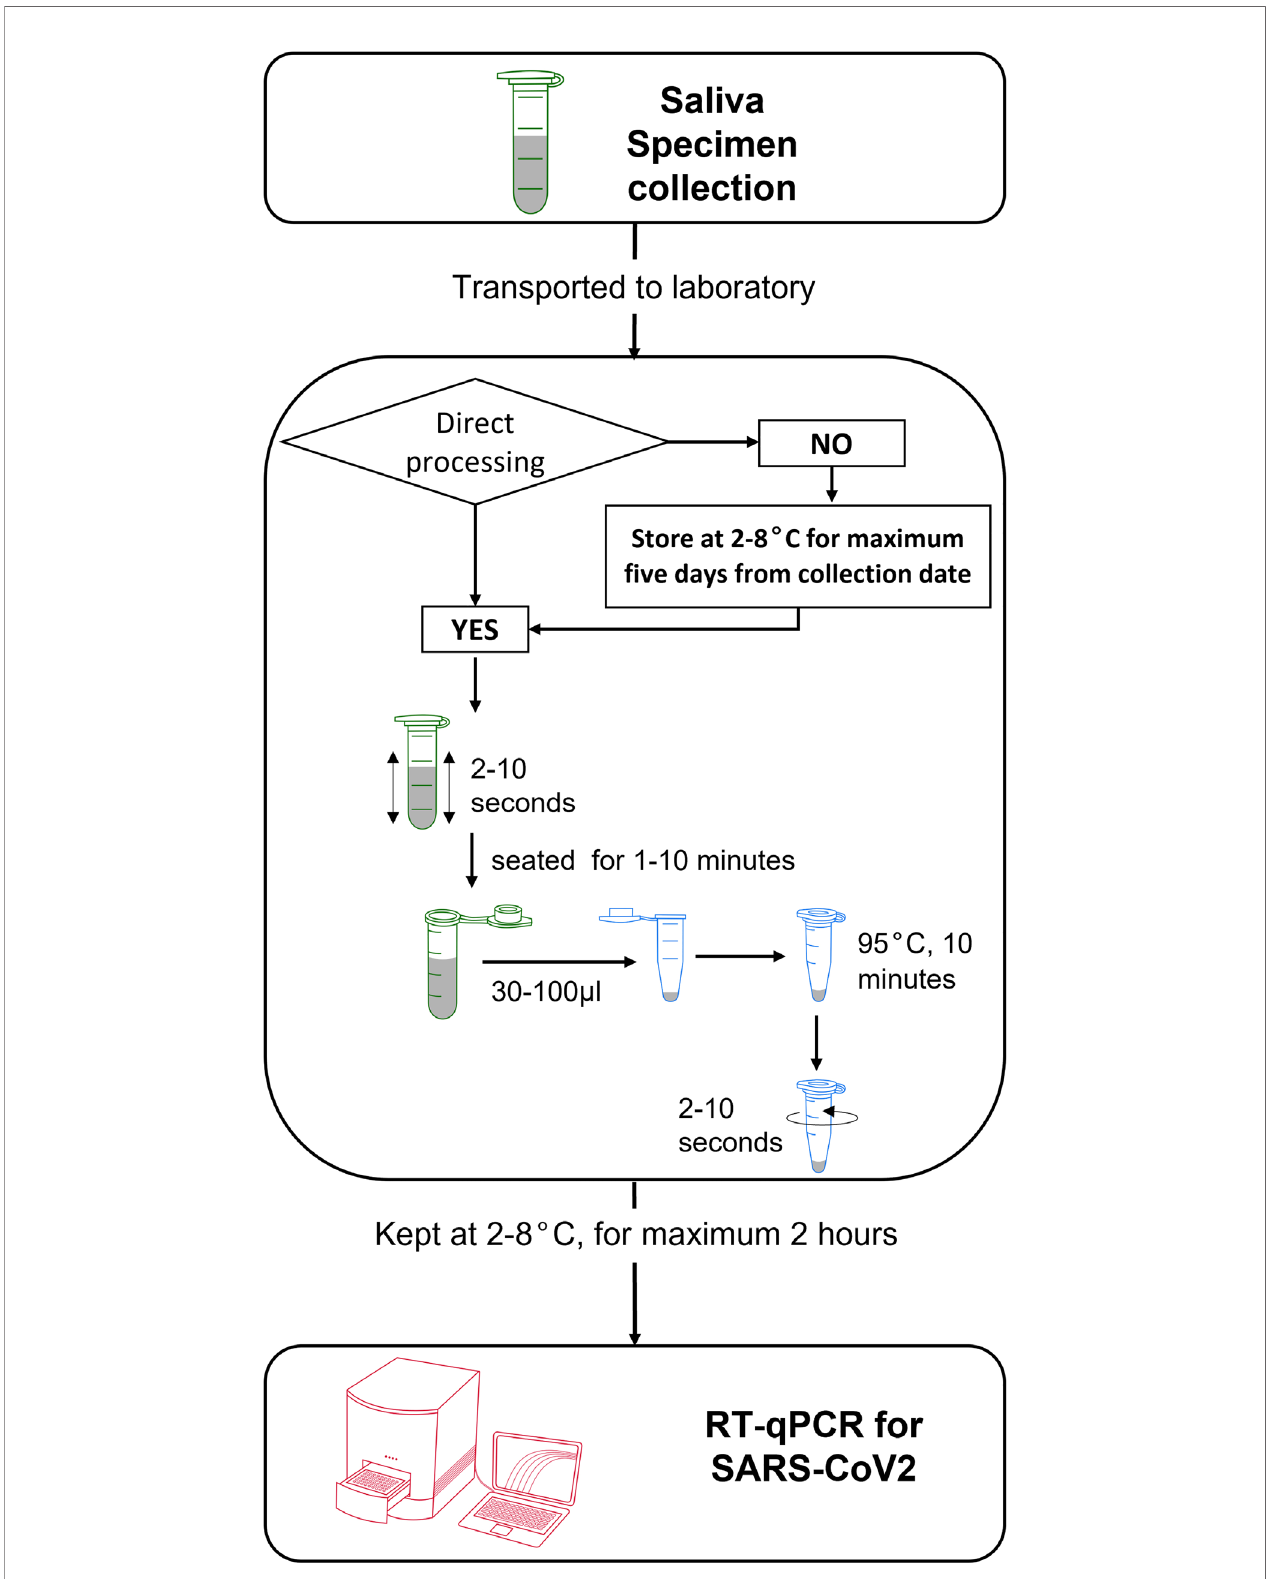
FIGURE 4 | Schematic work fl ow for collection and treatment of human saliva specimen for RNA-extraction-free detection of SARS-CoV-2 via RT-qPCR.